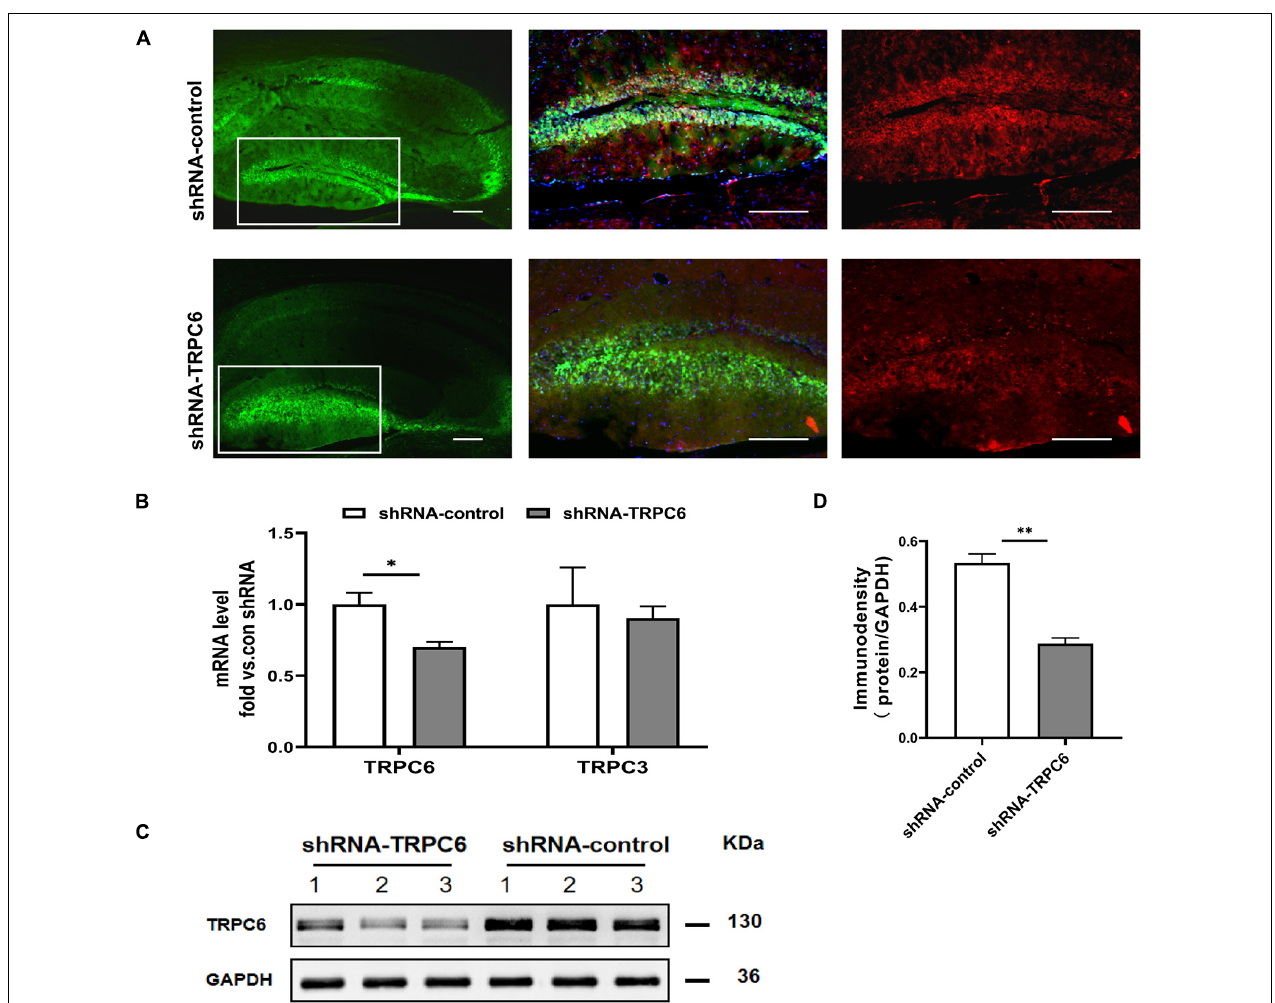
FIGURE 2 | shRNA-TRPC6 injection down-regulated TRPC6 expression in the hippocampus of animals. (A) Double immunofluorescent staining for TRPC6 (red) and AAV expressions (green) in the hippocampus of control shRNA- and TRPC6 shRNA- injected mice. (B) TRPC6/TRPC3 mRNA expression in shRNA-control and shRNA-TRPC6 treated mice by qRT-PCR. (C) Representative image of western blotting for TRPC6 protein in hippocampus of two groups of mice. (D) Densitometric quantification of TRPC6 showing decreased expression in shRNA-TRPC6 treated mice. ( n = 3, P < 0.05; t -test). Data were presented as mean ± SEM. * p < 0.05, ** p < 0.01. Scale bar: 10 µ